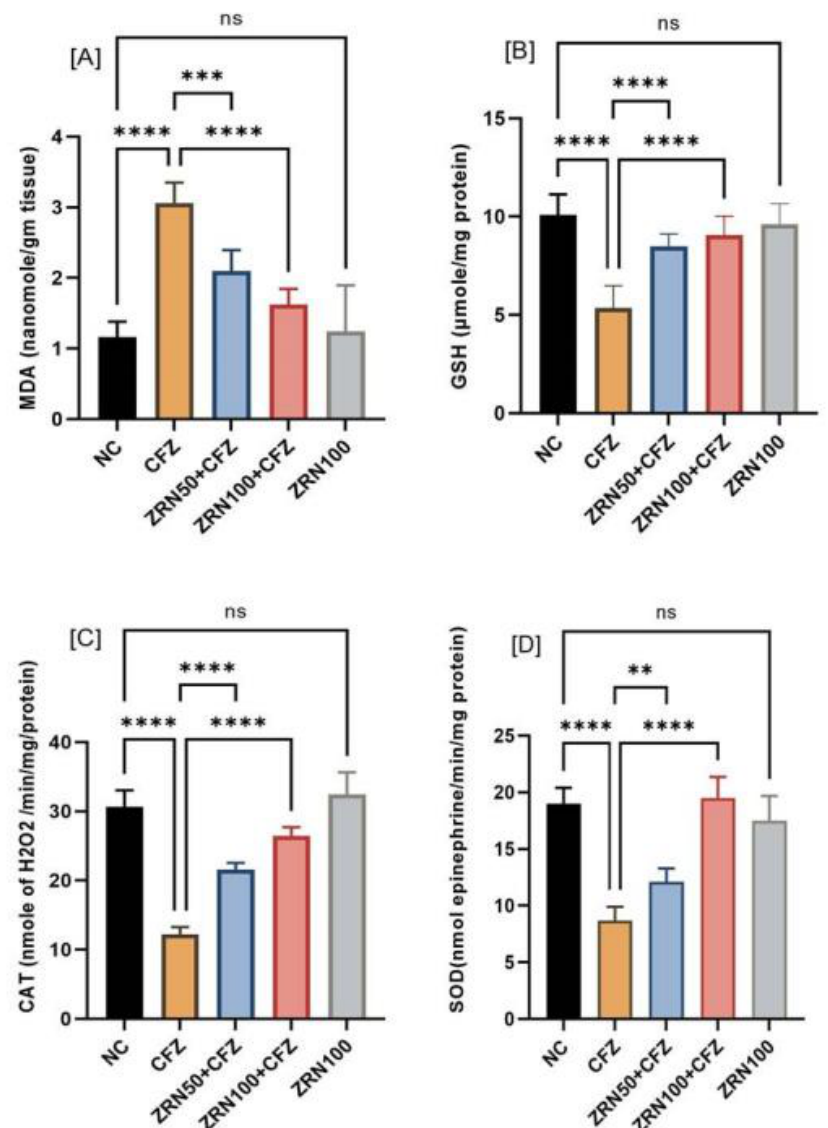
Figure 2. ( A – D ) The effect of zingerone on oxidative stress after carfilzomib administration in rats. Data are represented as the mean ± sd ( n = 8). The contents of MDA increase significantly (**** p < 0.0001) in CFZ as compared to NC after carfilzomib administration. Reduced glutathione (GSH), catalase (CAT), and superoxide dismutase (SOD) were significantly reduced (**** p < 0.0001) after CFZ administrations. The pretreatment of zingerone significantly decreased in MDA level and significantly enhanced in antioxidants such as reduced glutathione, catalase, and superoxide dismutase. There were no significant changes seen with high-dose treatments of zingerone alone in LPO, GSH, CAT, and SOD. Abbreviations: NC: Normal control, CFZ: Carfilzomib, ZRN: